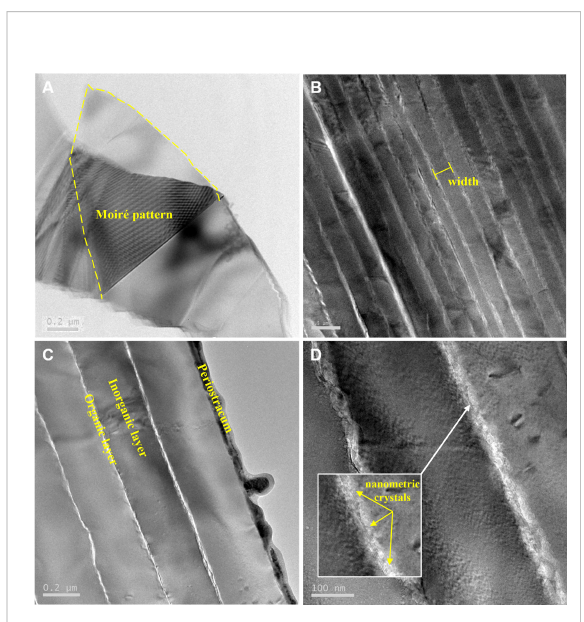
FIGURE 2 TEM images of deep-sea limpet E. crystallina shells at a depth of 2,700 m in the Southwest Indian Ocean. (A) Plane-view image showing the exfoliation property of the E. crystallina shell; (B – D) cross-sectional images showing multilayered microstructures of E. crystallina shells at different magni fi cations.